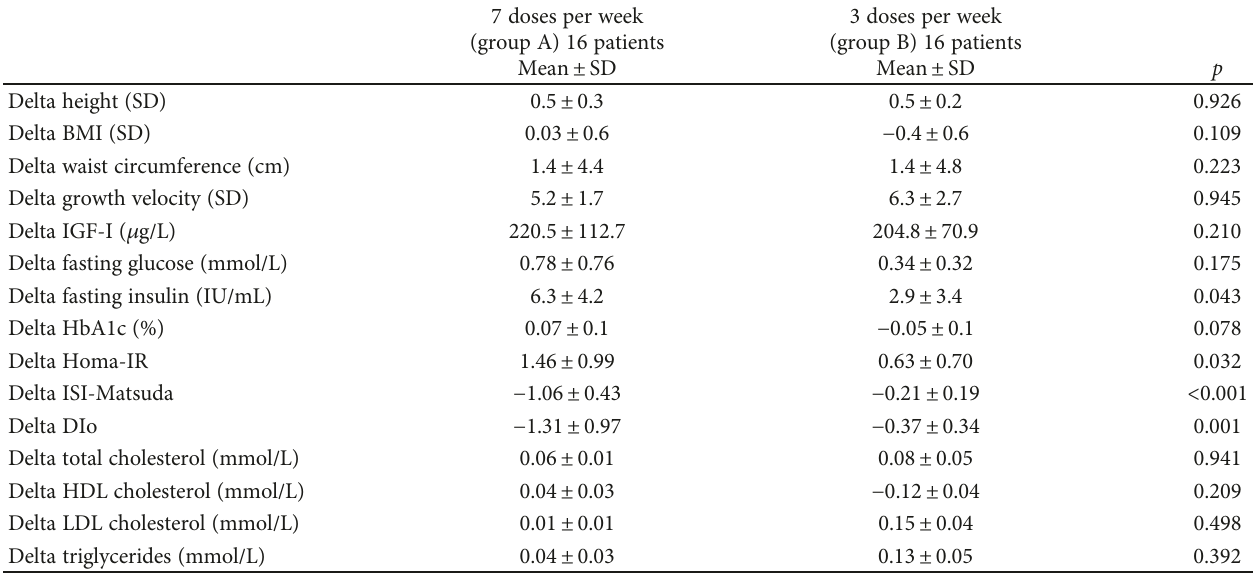
Table 4: Change (delta) in clinical and metabolic parameters from baseline to 12 months of GH treatment of patients grouped according to the GH treatment regimen.